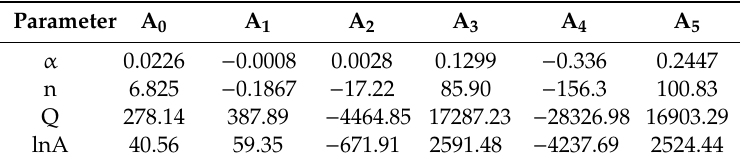
Table 2. Coefficients of α , n, lnA, and Q in Equation (13).